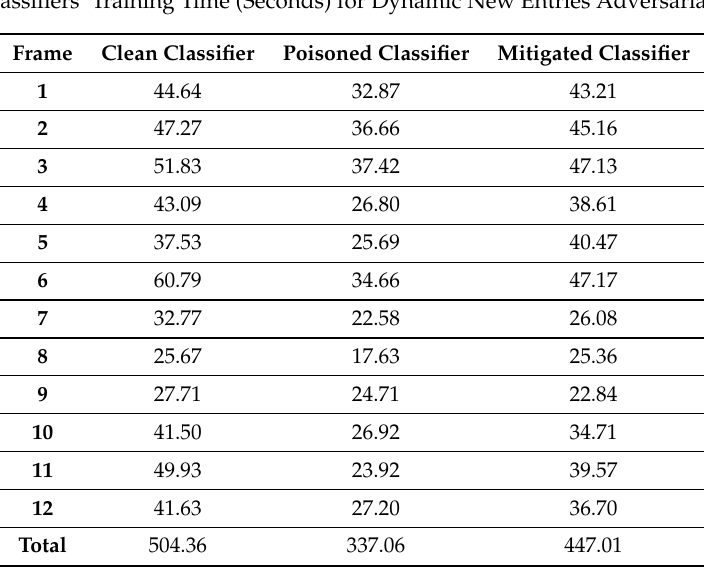
Table 8. Classifiers’ Training Time (Seconds) for Dynamic New Entries Adversarial